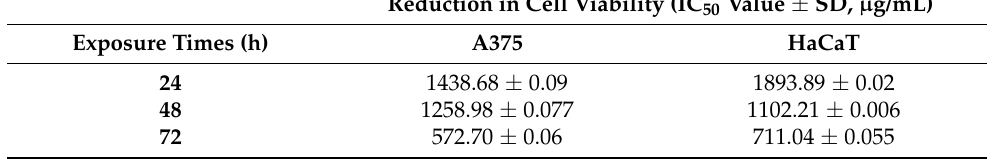
IC 50 : Represents the concentration of extract that is required for 50% inhibition of cell viability. SD; Standard deviation.